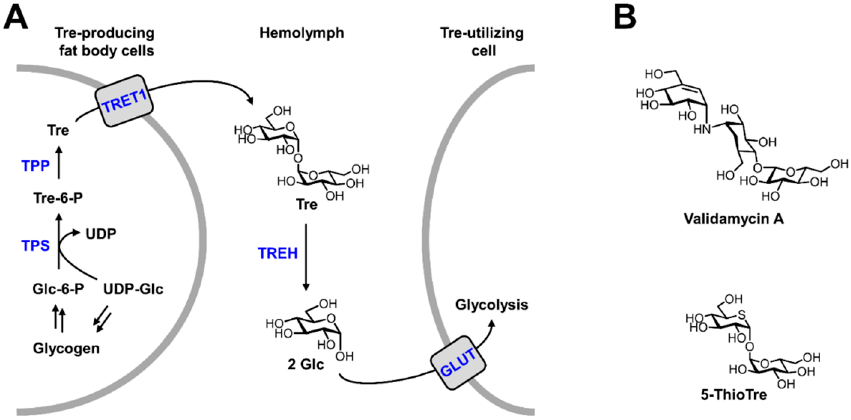
Figure 2. ( A ) Overview of major stored sugar pathways in mosquitoes, with a focus on trehalose metabolism. ( B ) Structures of trehalase inhibitors validamycin A and 5-ThioTre.